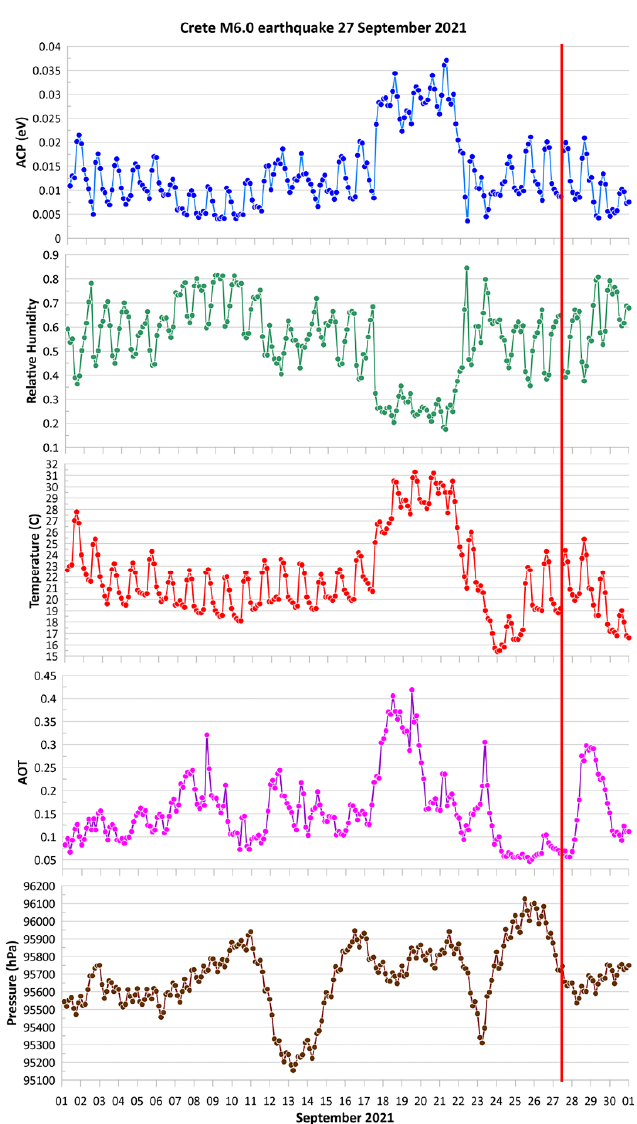
Figure 12. From top to bottom: ACP, relative humidity, air temperature, AOT and air pressure over the Crete M6 earthquake epicenter at a 250 m altitude. The earthquake moment is marked by the vertical red line